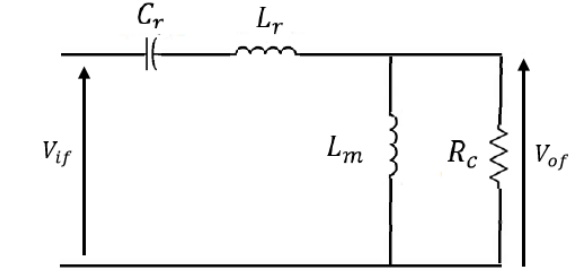
Figure 3. FHA equivalent model of LLC converter in G2V